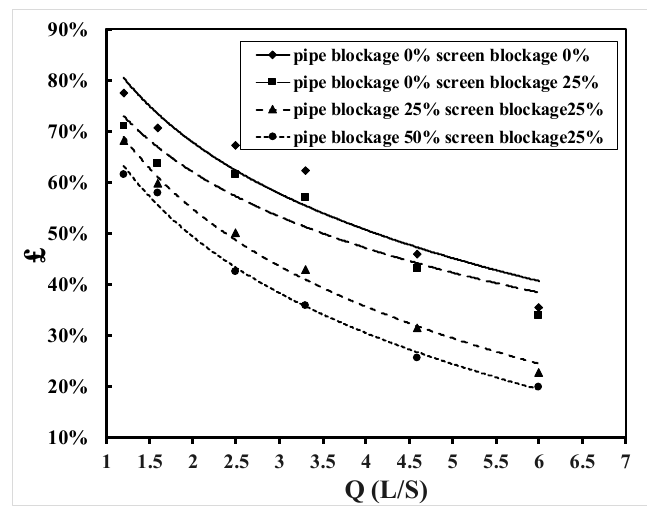
Figure 25. Relationship between £ and Q for different ratios of blockage height at surface blockage 25%.